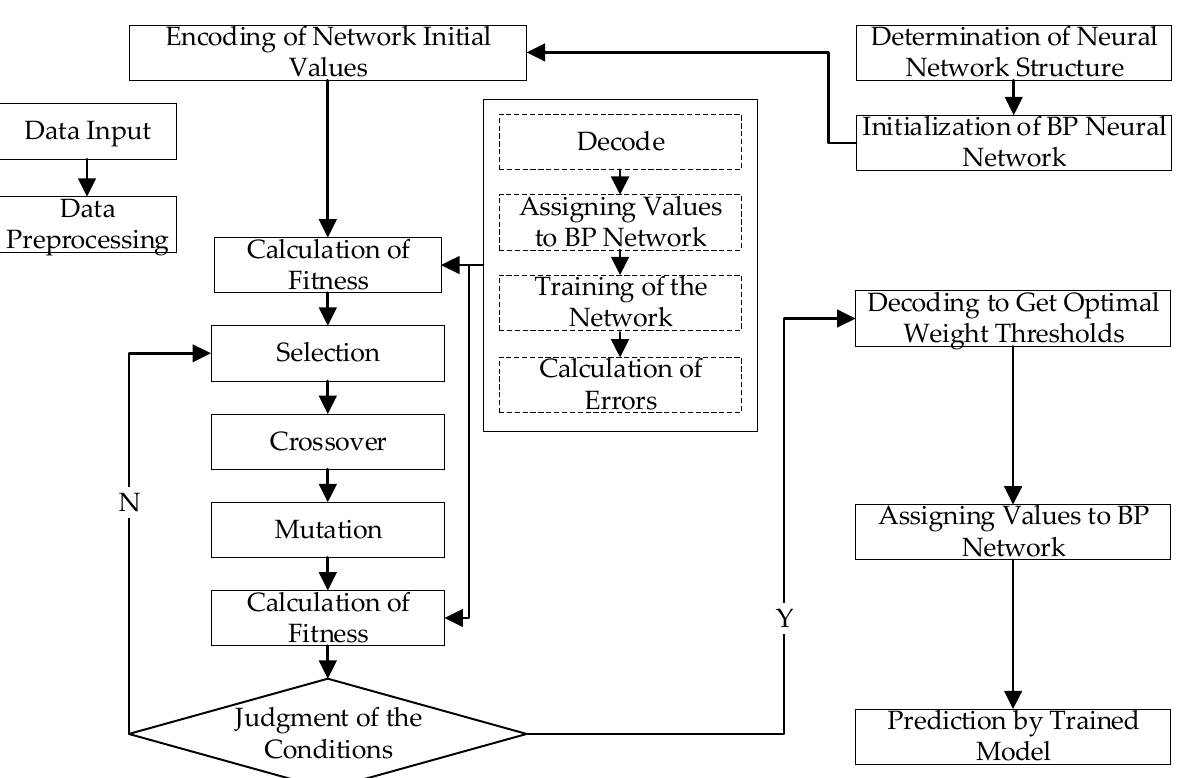
Figure 2. The flow chart for optimizing the BP neural network using AGA.